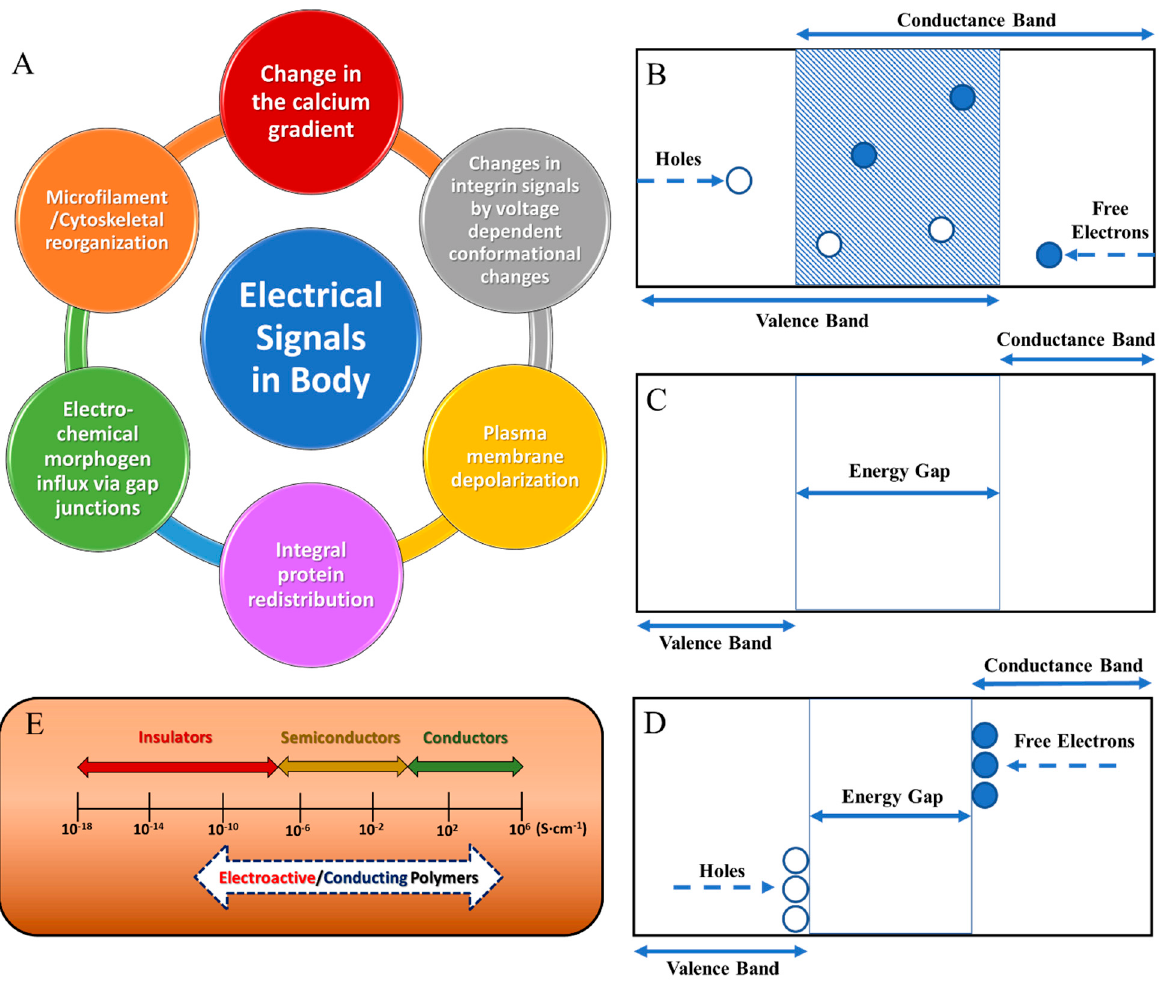
Figure 1. ( A ) Different electrical signals utilized in the body. Energy gap representations for ( B ) conductors, ( C ) insulators, ( D ) semiconductors, and ( E ) conductivity ranges for these material classifications compared to typical conducting/electroactive polymers.